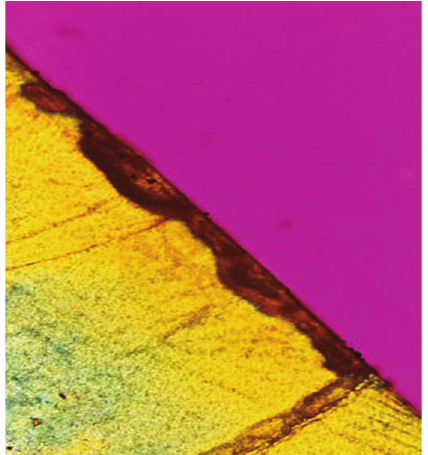
Figure 4: The largest caries depth [ d ] is measured. (Figure 3). The teeth were sectioned and imaged by polarized light microscopy (Figure 4). The deepest demineralization depth was measured as distance “ d ” by imageJ software. The largest depth data of demineralization and the most percentage loss of fluorescence are listed in Table 1.